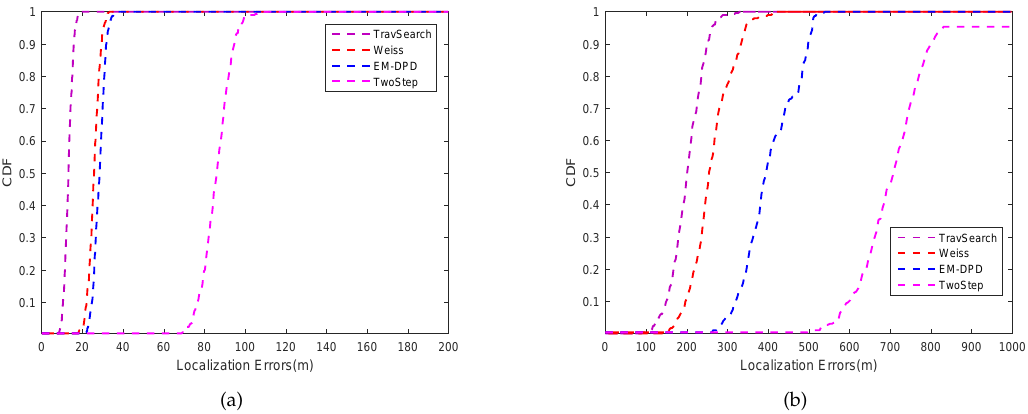
Figure 4. The CDF of different algorithms versus localization errors: ( a ) SNR = 5 dB; ( b ) SNR = ´ 10